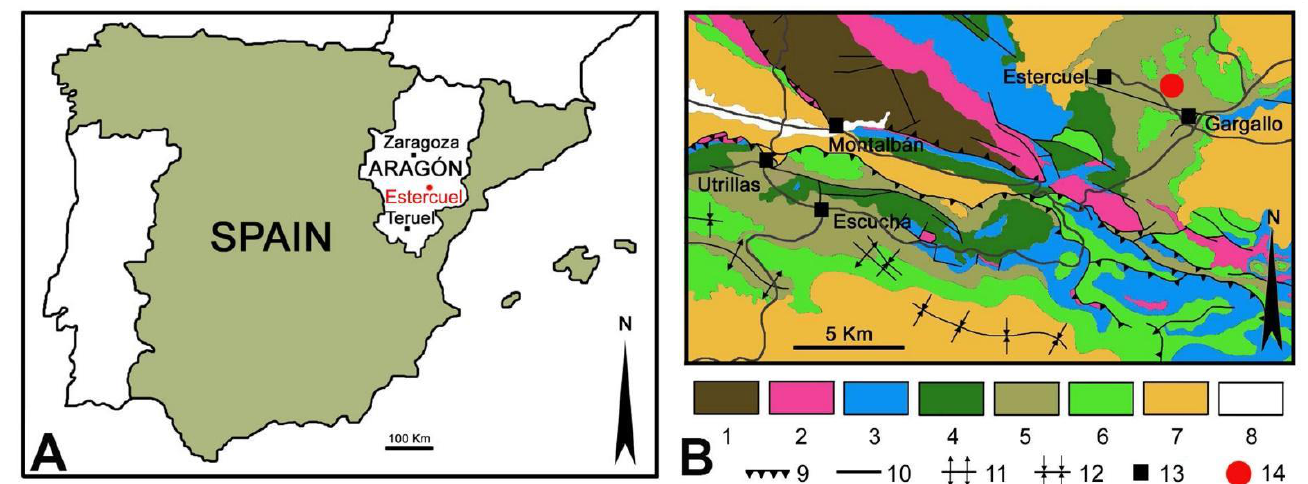
Figure 1. A. Geographic map with location of the Estercuel locality in the Aragón region (Spain). B. Geological map of the studied area and nearby setting. Legend of the map: 1 Carboniferous, 2 Triassic, 3 Jurassic, 4 Early Cretaceous, 5 Albian, 6 Late Cretaceous, 7 Oligocene – Miocene, 8 Quaternary, 9 Thrust belt, 10 Fault, 11 Anticline, 12 Syncline, 13 Localities, 14 Fossil site with insect – plant interactions. Both maps were modified from [21].